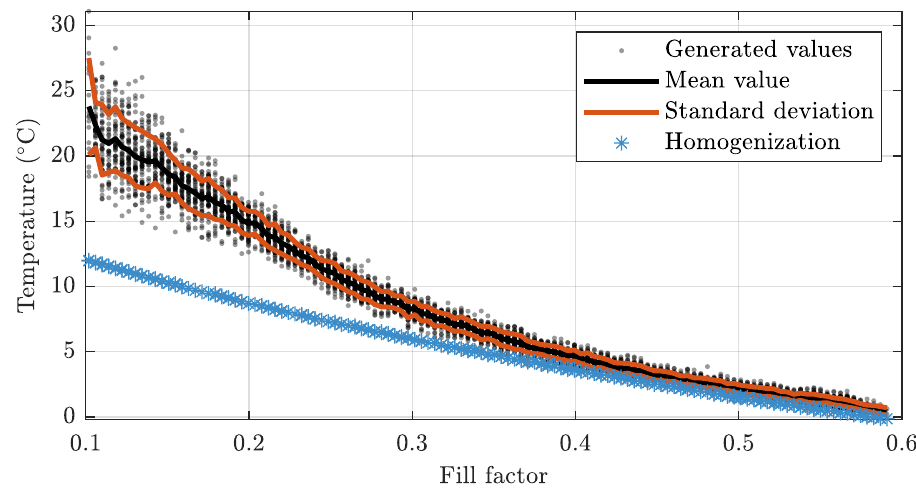
Figure 10. Maximum temperatures of L-type